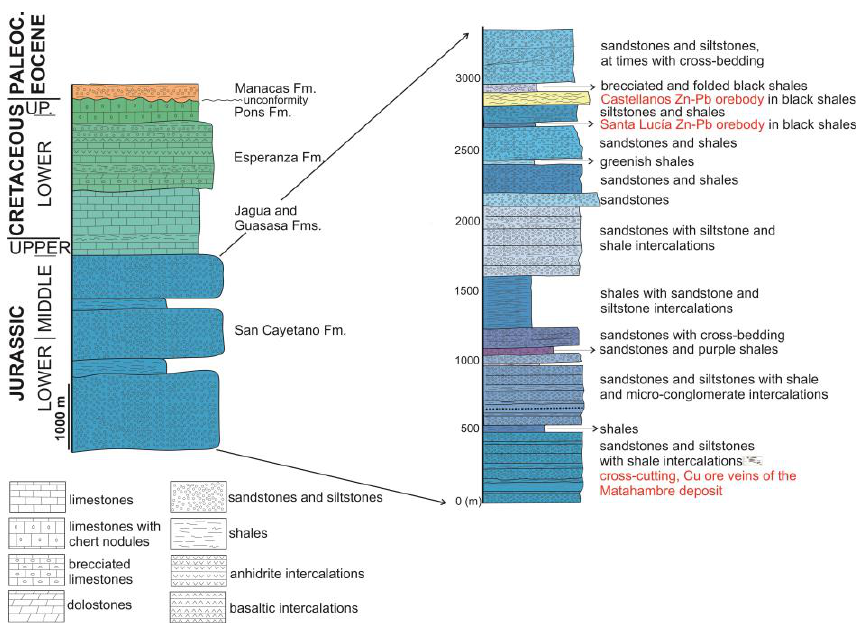
Figure 1. Geological map of the north-west (NW) zone of the Sierra de Los Ó rganos in NW Cuba, showing the location of the most important mineral deposits: C: Castellanos, SL: Santa Lucía, MM: Minas de Matahambre, N: Nieves and M: Mella. Modified from [16].